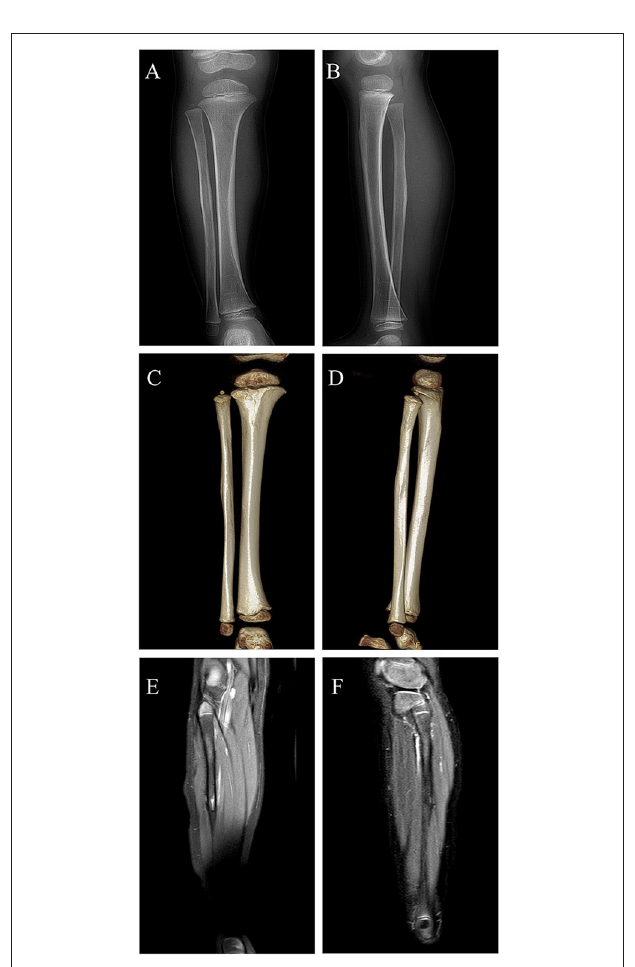
FIGURE 4 | Digital radiograph at 2 years postoperatively: (A,B) Radiographs showing reformation of the cortex of the proximal fibula; (C,D) 3d CT reconstruction demonstrating both uniform bone mineral density and continuous cortical of right proximal fibula; (E,F) MRI revealing remarkable regression of lesion without evidence of local